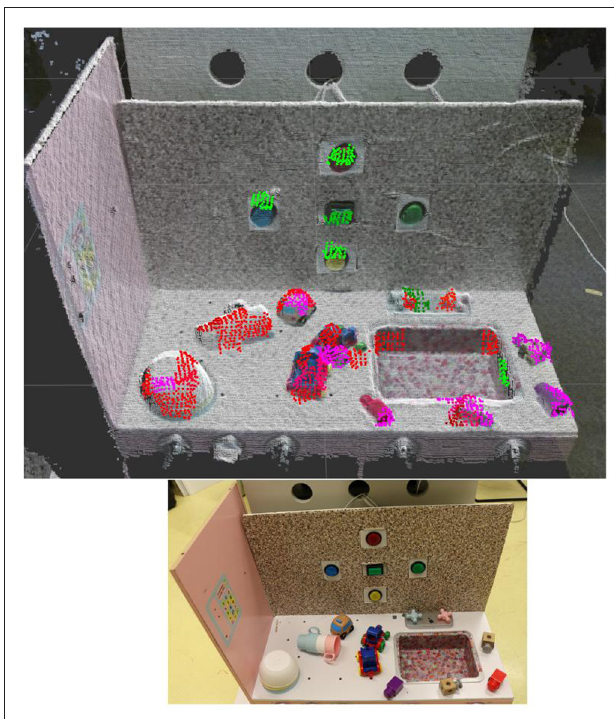
FIGURE 13 | Affordances map of liftable pressable buttons and pushable affordances. Colored areas indicate areas classified with a probability above 0.5, in red to afford the push primitive, in purple to afford the lift primitive and in green to be an pressable buttons. The bottom picture represents the environment on which the affordances map has been